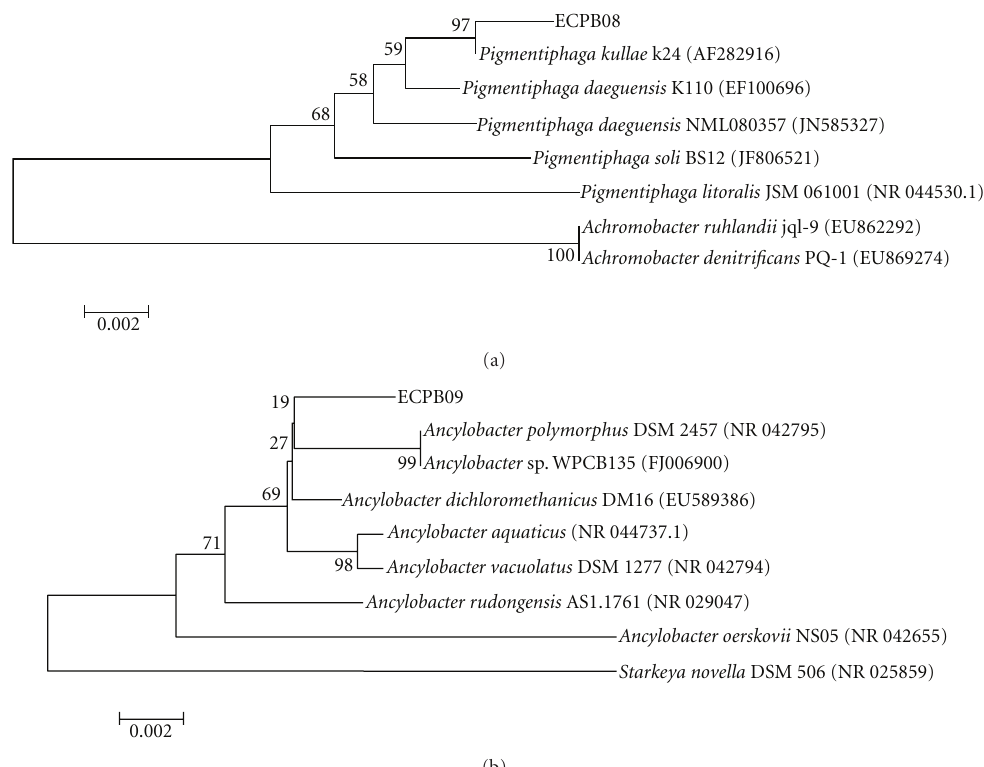
Figure 1: Phylogenetic tree based on 16S rRNA sequences by Maximum Parsimony analysis. ECPB08 (JQ345720) and ECPB09 (JQ345721) are the codes for the isolates. In parentheses are the GenBank codes. The relationship between ECPB08 (JQ345720) (a), ECPB09 (JQ345721) (b) related taxa, and the outgroups Achromobacter ruhlandii, A. denitrificans, and Starkeya novella is shown. The bootstrap consensus tree inferred from 1000 replicates is taken to represent the evolutionary history of the taxa analyzed. Scale of 0.002: evolutionary distance.